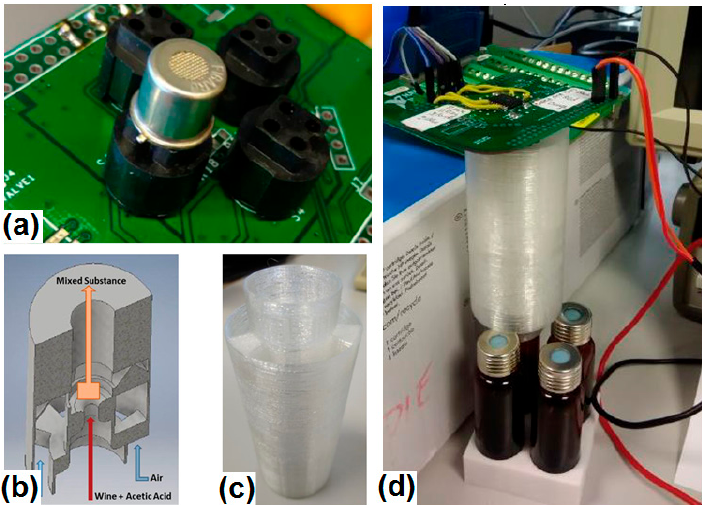
Figure 3. ( a ) The TGS2620 module; ( b ) the Venturi tool design; ( c ) the manufactured Venturi tool; ( d ) the measurement setup with the Venturi tool.